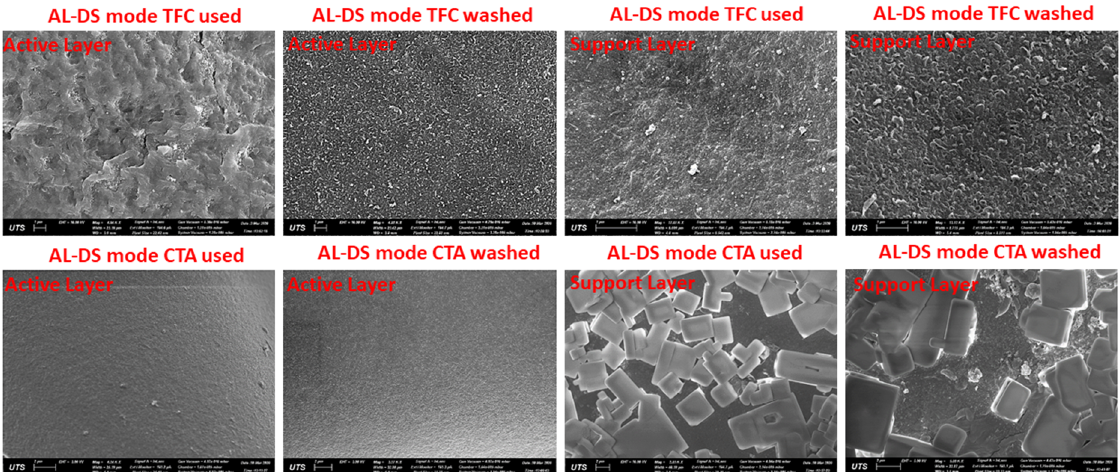
Figure 8. SEM images of the active and support layer of used and washed TFC and CTA membranes. Images show fouling layer in the active and support layer of the membranes used in the FO process conducted with 2 bar hydraulic pressure.